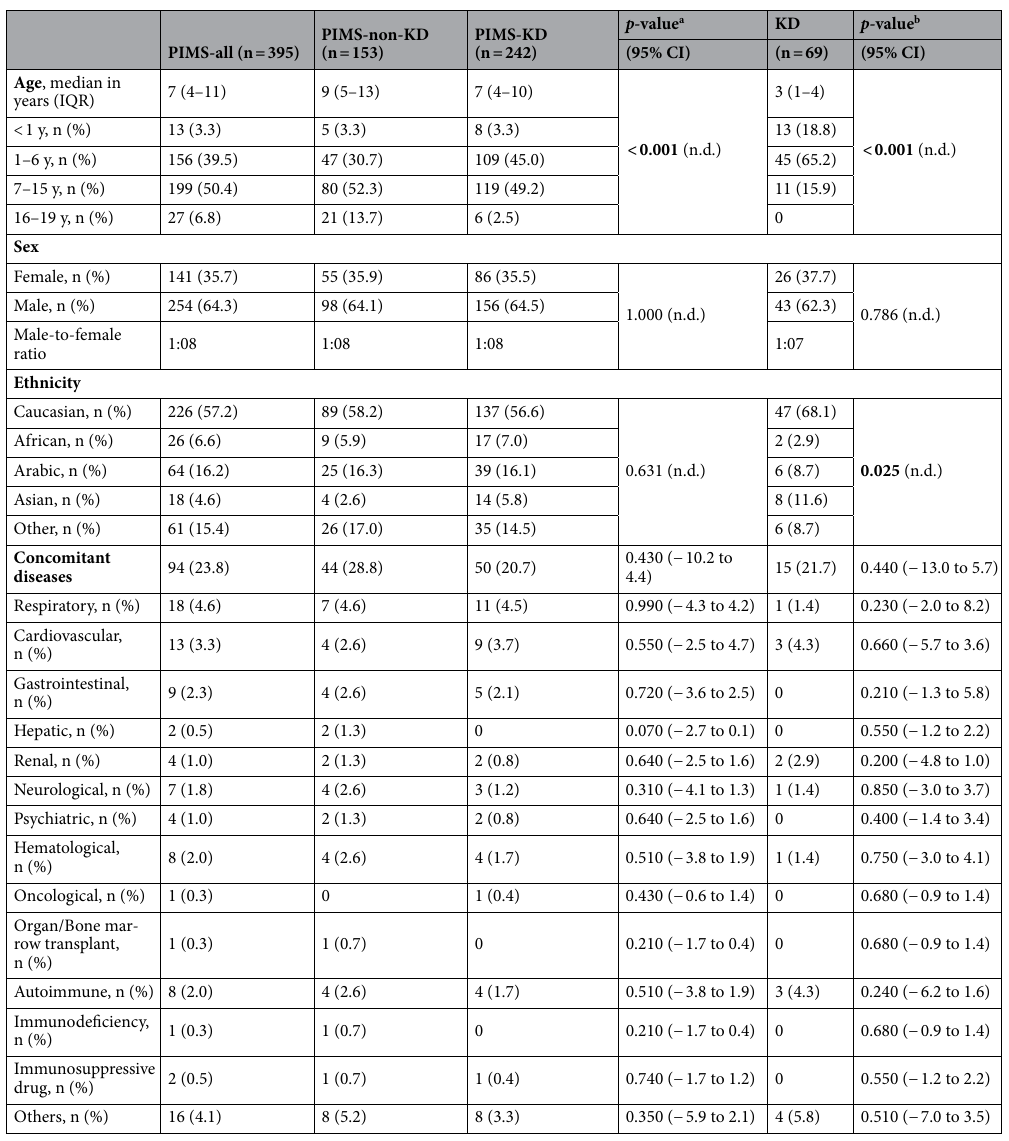
Table 1. Clinical characteristics of patients with PIMS-all, PIMS-non-KD, PIMS-KD and KD. PIMS, pediatric multisystem inflammatory syndrome; KD, Kawasaki disease. a comparison between PIMS-non-KD and PIMS-KD. b comparison between PIMS-all and KD; 95% CI, 95%-confidence interval; n; number of cases; IQR, interquartile range; y, years; n.d.; not determined. P values in bold are considered statistically